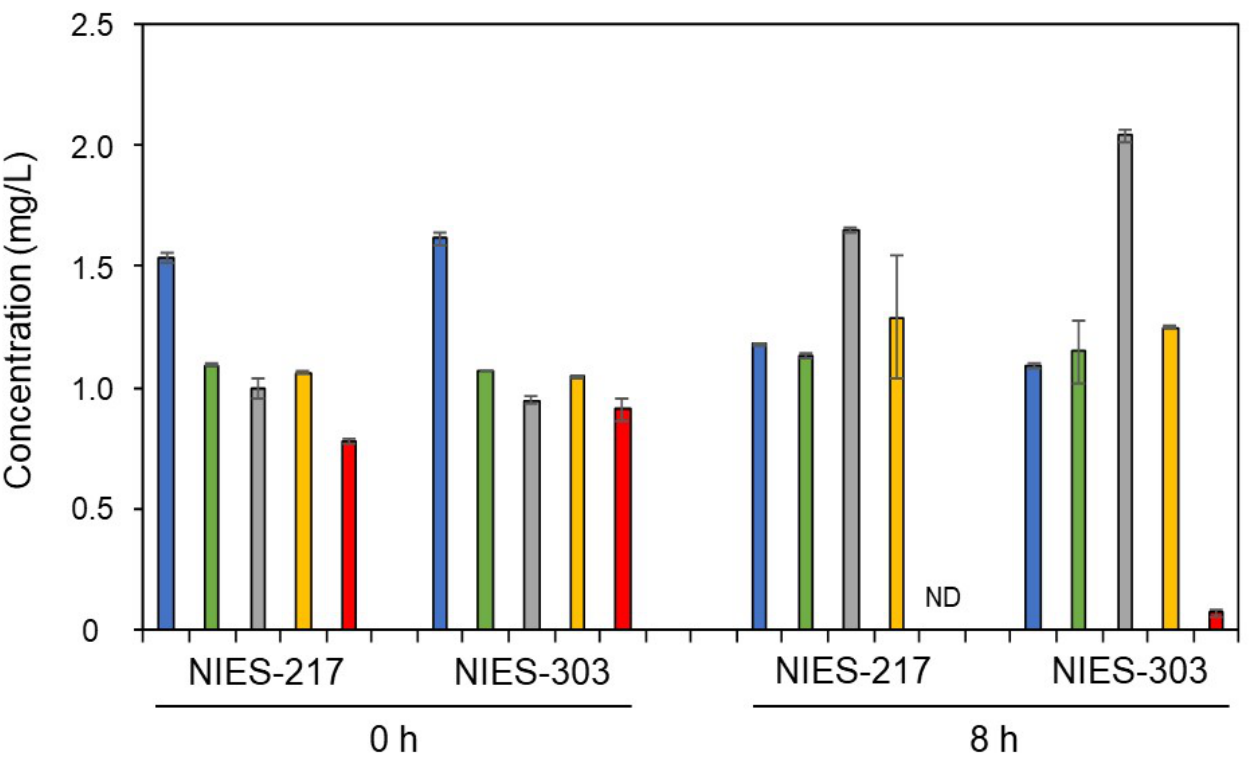
Figure 4. Specificity of Pb removal in the presence of divalent and monovalent cations during the soaking immobilized cells in the aqueous solution. Blue (Na), green (K), gray (Ca), yellow (Mg), and red (Pb) bars with an error bar show the means ( n = 3) ± SD at 0 h and after soaking for 8 h. ND indicates that Pb was not detected.